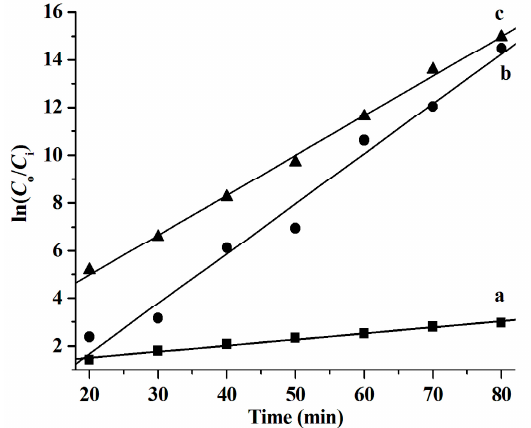
Figure 6. The rhodamine B (RhB) degradation efficiency catalyzed by the CuS produced from different systems. (a) [C 4 C 2 OOHim]NTf 2 /TAA (80 °C, 4 h), (b) [C 4 C 2 OOHim]NTf 2 /Na 2 S, and (c) [C 4 C 2 OOHim]NTf 2 /TAA (80 °C, 6 h); 5 mg of CuS, 25 mL of RhB (10 mg L − 1 ), and 1.0 mL of H 2 O 2 (30 wt.%).